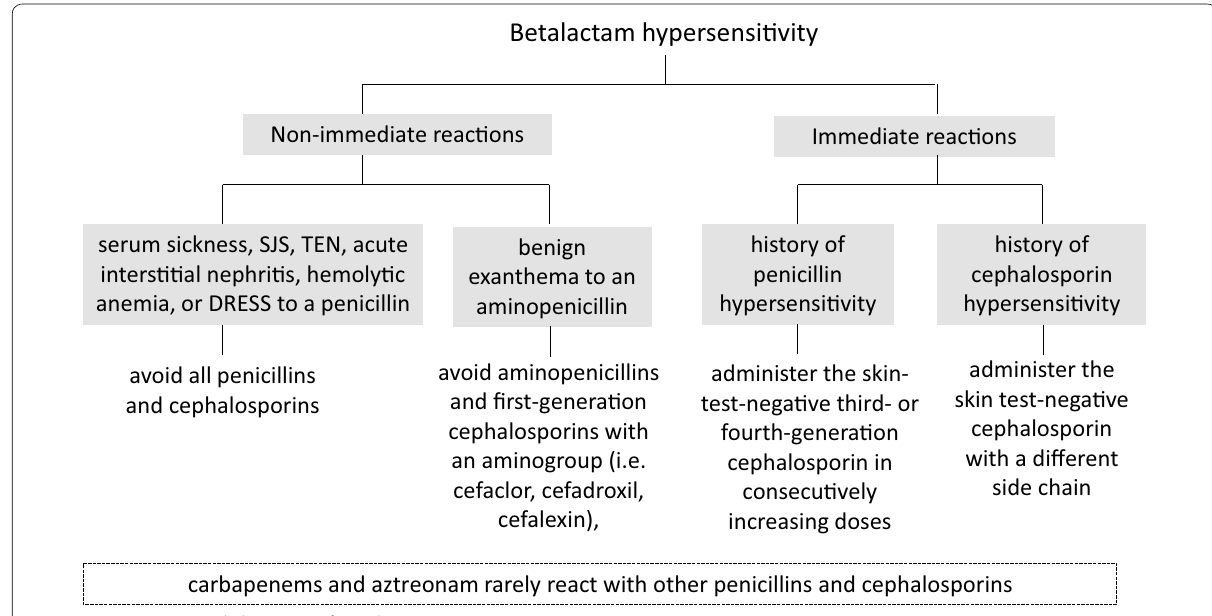
Fig. 3 Management and alternatives for BL hypersensitive